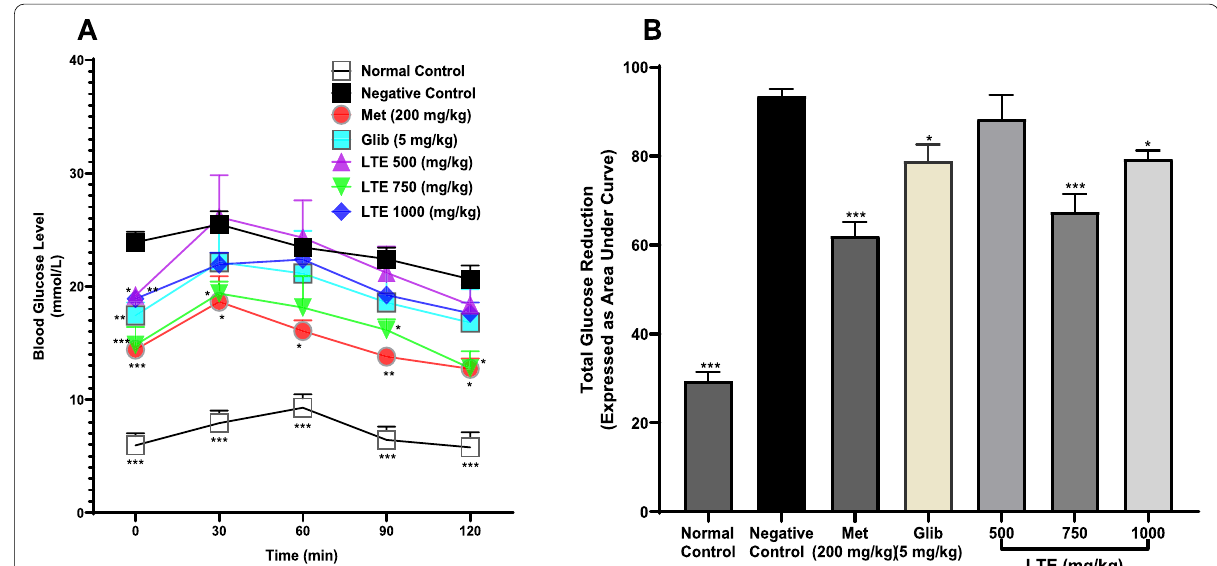
Fig. 3 A 2‑hour OGTT of the various treatments ( A ) vs. Total AUCs of the 2‑hour OGTT study ( B ). All values were expressed as mean Data were analyzed using two‑way ANOVA for 3A and one‑way ANOVA for 3B, followed by Dunnett’s multiple comparisons test. * represents statistical significance at p < 0.05 vs. the negative control